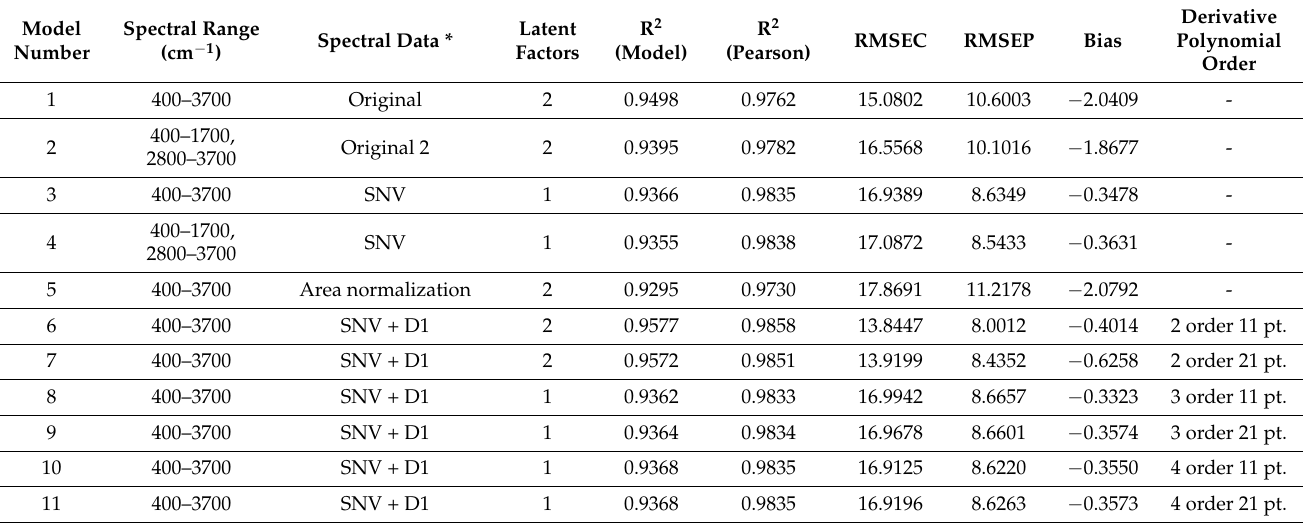
Table 3. The developed PLSR models and model parameters of granules.